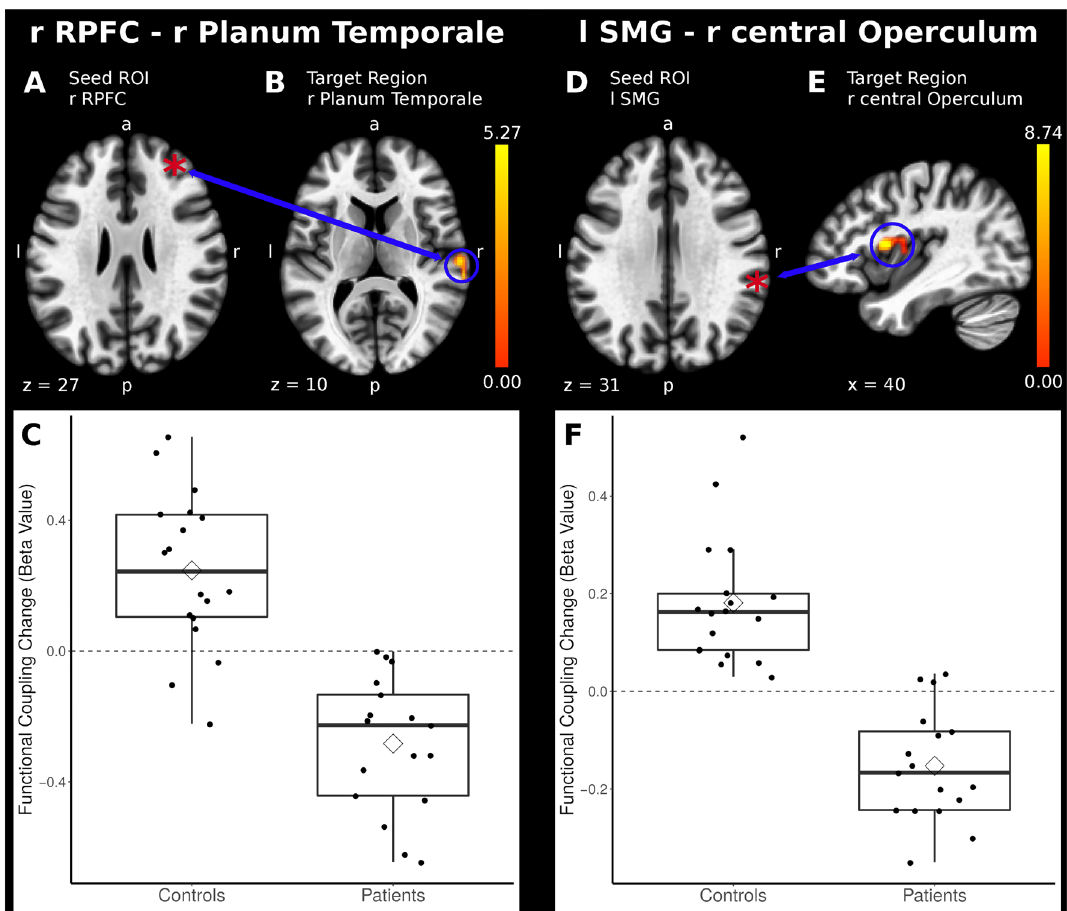
Figure 1. Within the salience network, the seeds rostral prefrontal cortex and supramarginal gyrus (SMG) demonstrated a decrease in mechanosensory-related functional connectivity with the temporal and opercular region as a function of behavioral adaptation ( P < 0.05 FWE-corrected, the coordinates are displayed in Table 2). Below are the boxplots of the Beta Values for the patients and control